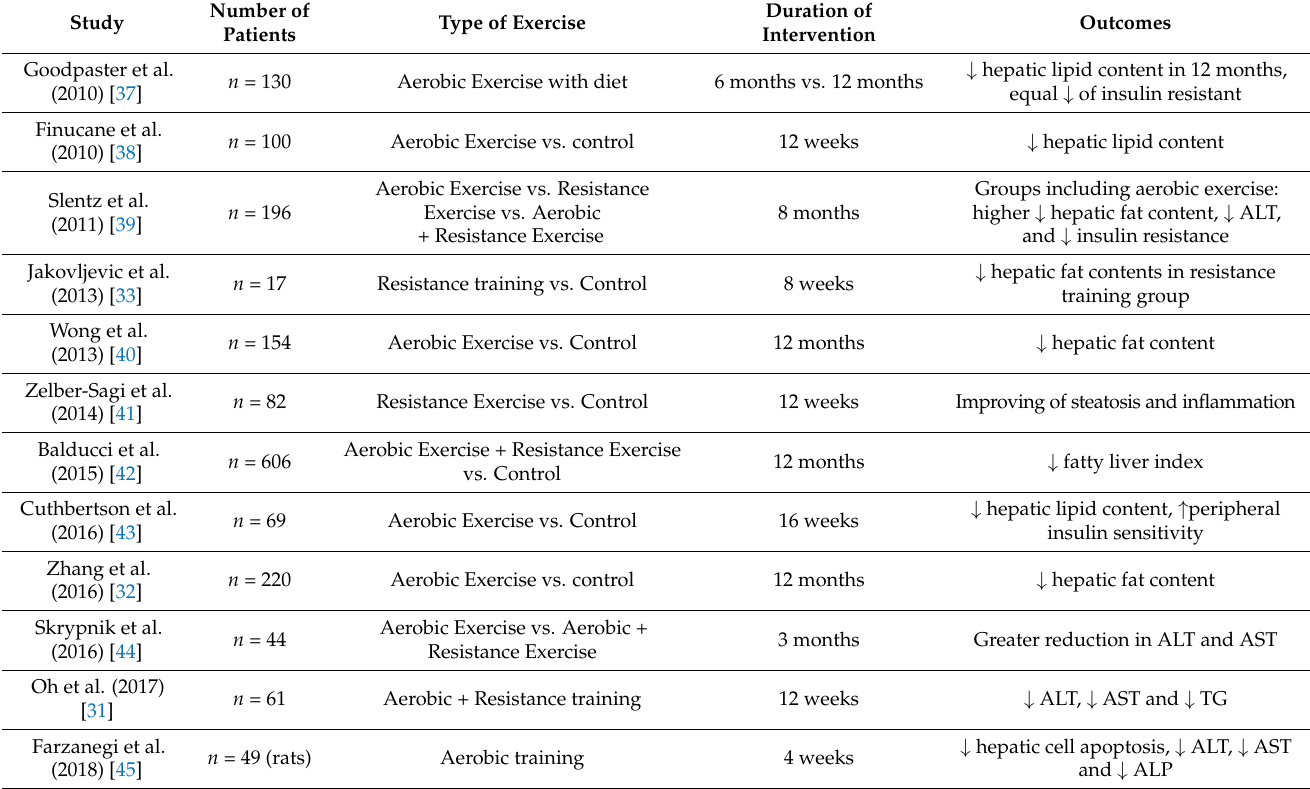
Table 1. Effects of exercise in patients with